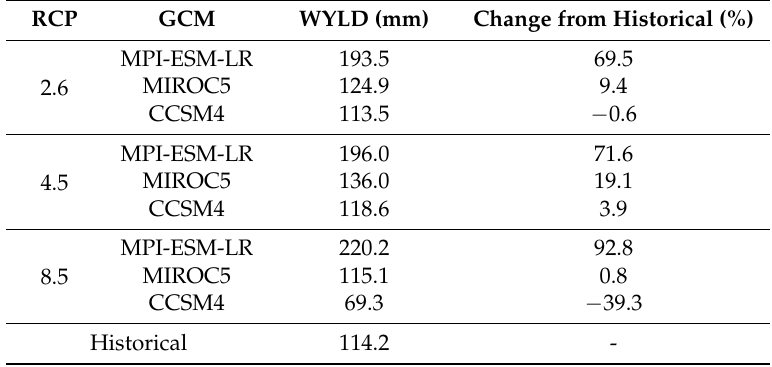
Table 5. Future water yield (WYLD) as modeled by future climate compared to the historical yield.